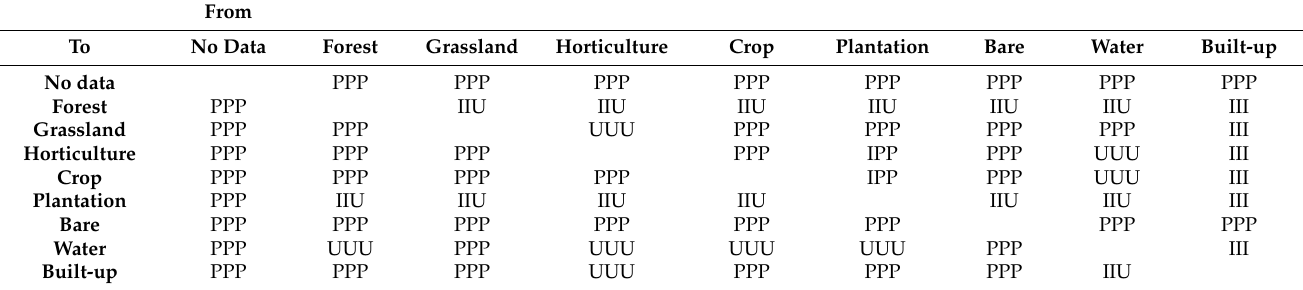
Table 2. Matrix showing one (first letter), four (second letter) and eight-year (third letter) transitions, respectively, of mapped land cover and their likelihood: Possible (P), unlikely (U) or implausible (I) changes. No change transitions on diagonal (left